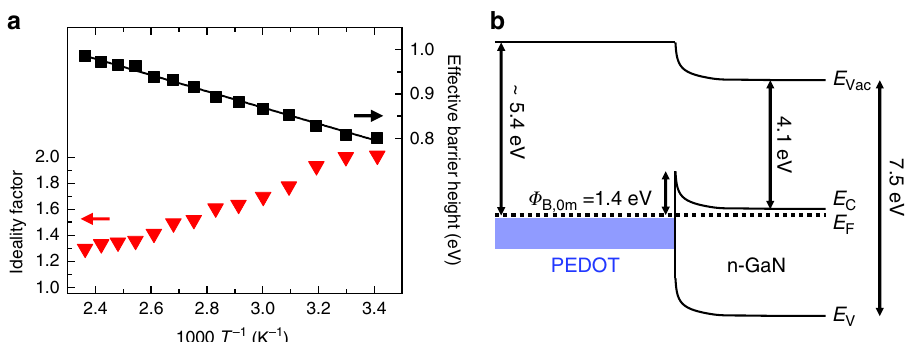
Fig. 3 Diode characteristics obtained for the hybrid GaN/PEDOT specimen. a Ideality factors and effective barrier heights obtained from the thermionic emission model for I – V measurements on the hybrid GaN/PEDOT specimen show temperature dependencies which are characteristic for lateral inhomogeneities. Evaluation of the characteristics with the model of thermionic emission over a laterally inhomogeneous barrier yields a mean barrier height of about Φ B,0m = 1.4 eV. The solid line represents a linear fi t according to Eq. (3) for the effective barrier height. b Band diagram of the hybrid n- GaN/PEDOT structure. E V , E F , E C , and E Vac correspond to the valence band, Fermi level, conduction band and vacuum